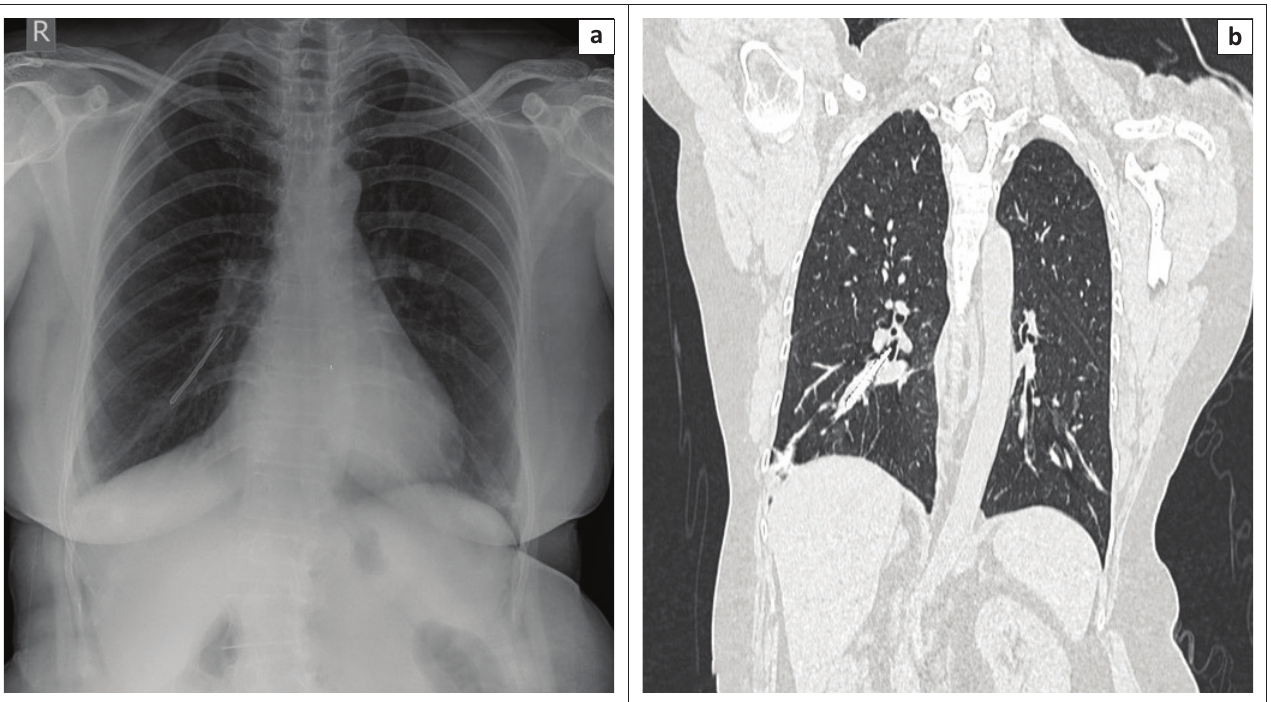
FIGURE 13: (a) Chest radiograph and (b) coronal reformatted chest computed tomography images of a 59-year-old lady who accidentally aspirated a hair pin (arrows) into the right lower lobe